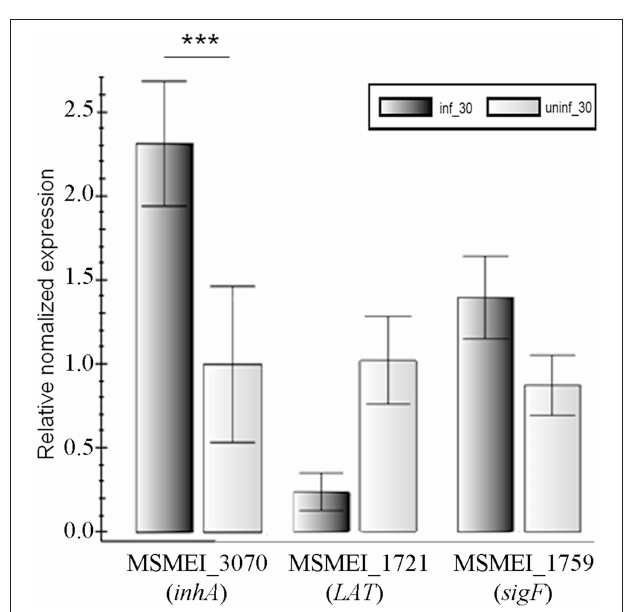
FIGURE 4 | Verification of RNA-seq results by real-time PCR. Numbers means the numbering of gene in M. smegmatis mc 2 155. The data were averaged from three independent experiments ± s.d. Significant differences ( *** p < 0.001